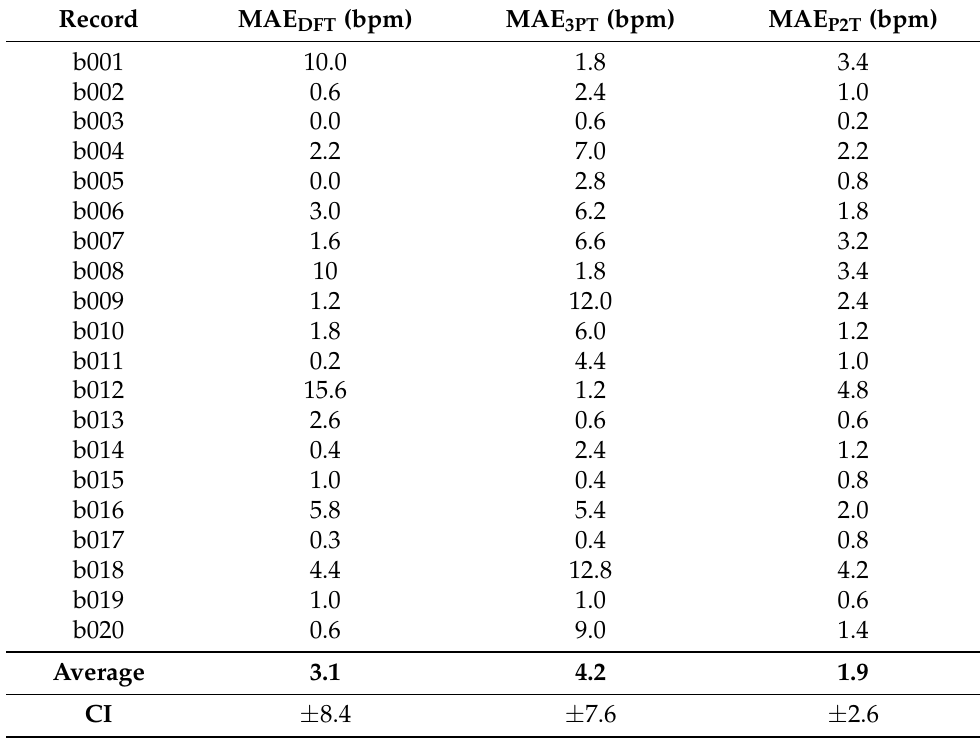
Table 2. S1 Intensity performance.